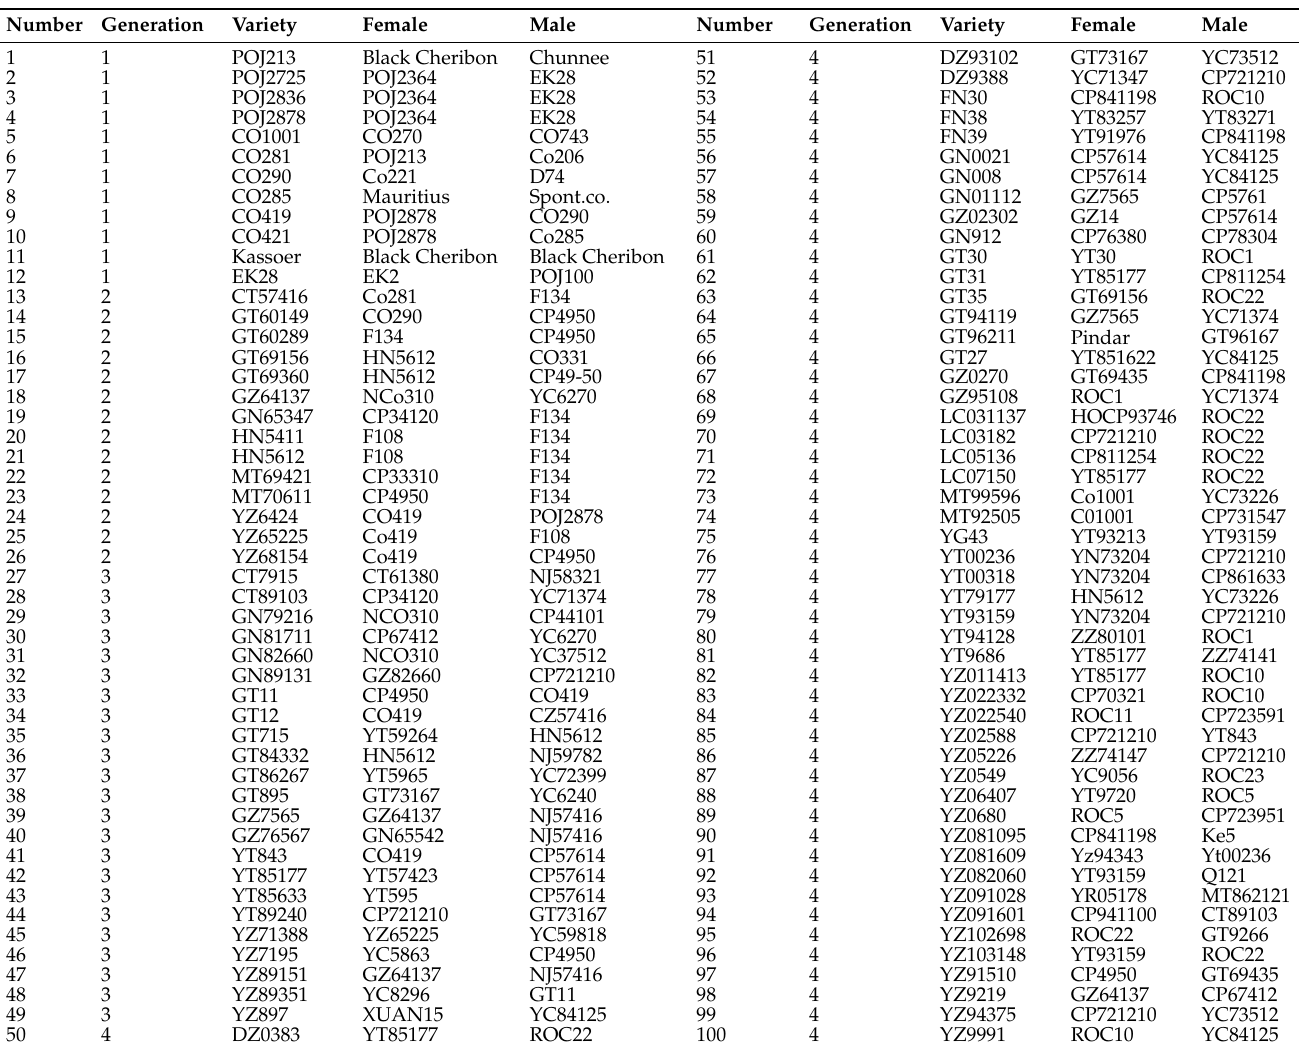
Table 1. Sugarcane test variety resources, their parents, and their classification into the four improved generations.